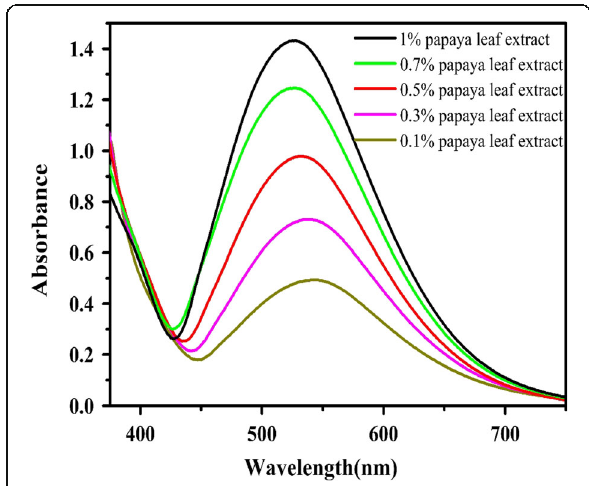
Fig. 1 The UV-vis absorption spectra of AuNPs synthesized by different concentration of papaya leaf extract solution at 1mM HAuCl